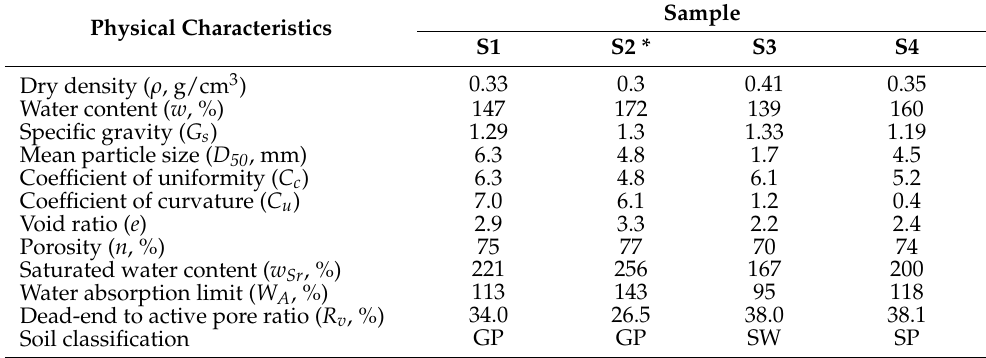
Table 2. Physical characteristics of